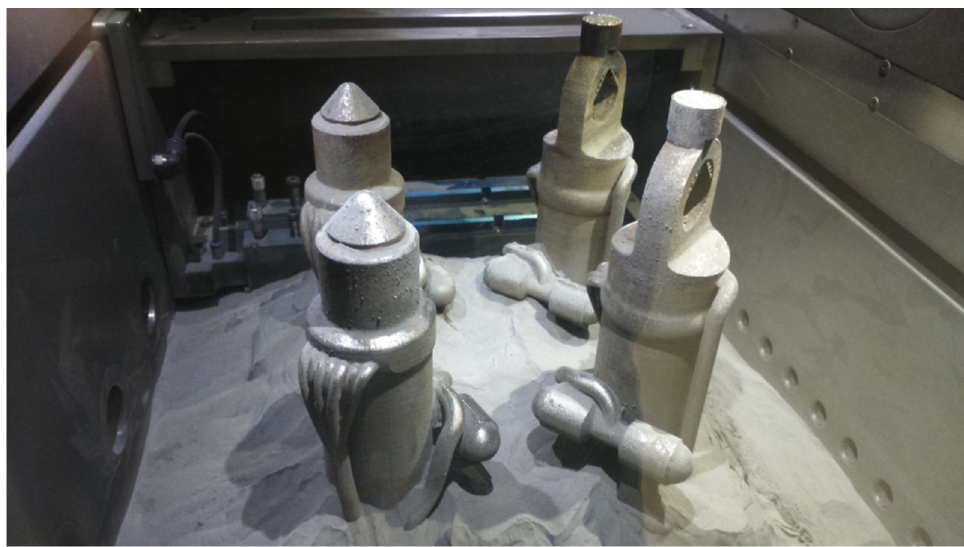
Figure 11. Manufacturing of actuator bodies with AM technology.